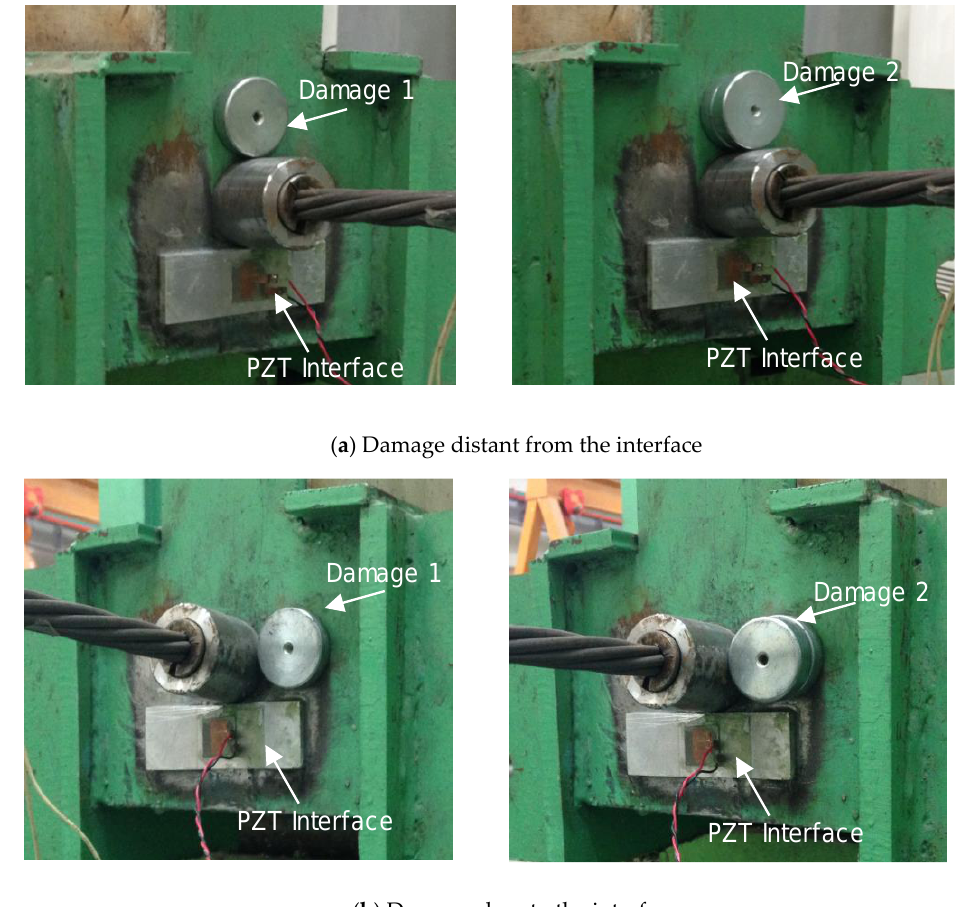
Figure 8. Simulation of damage scenarios in the prestressed anchorage.